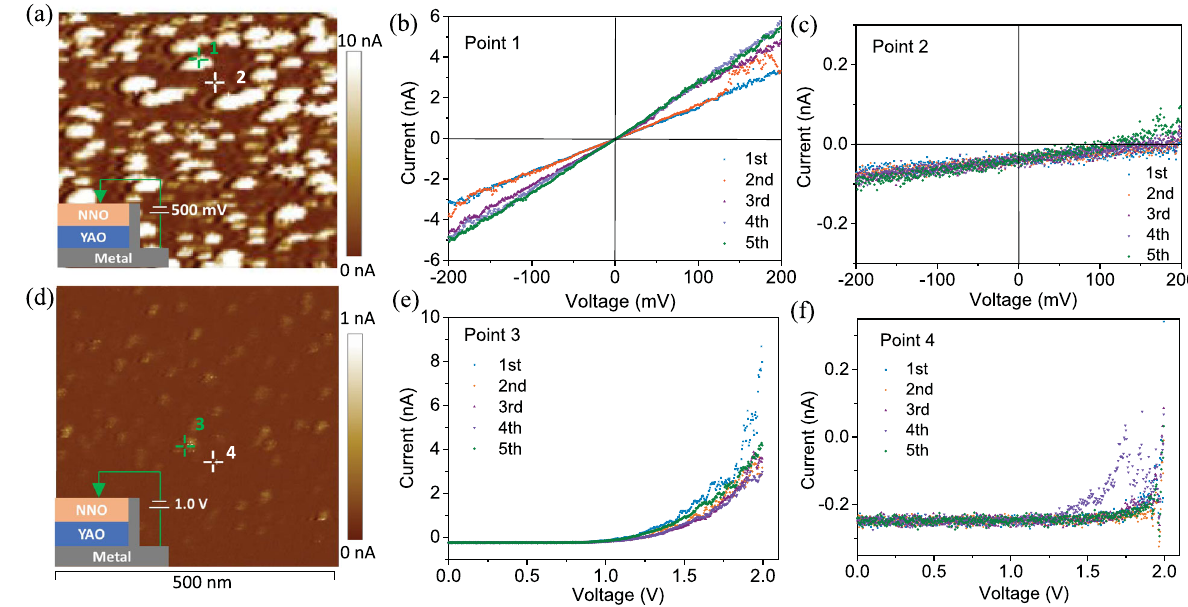
Fig. 3 Conductive Atomic force microscopy (c-AFM). a c-AFM image of the NNO/YAO fi lm after annealing at 800° for 1 h with a DC sample bias of 500 mV. The inset sketch illustrates the con fi guration of the c-AFM measurement. b , c show the I - V curves obtained from representative points 1 and 2 in a , respectively. d c-AFM image of the NNO/YAO fi lm after vacuum annealing with a DC sample bias of 1.0 V. e , f show the I - V curves obtained from representative point 3 and 4 in d , respectively.